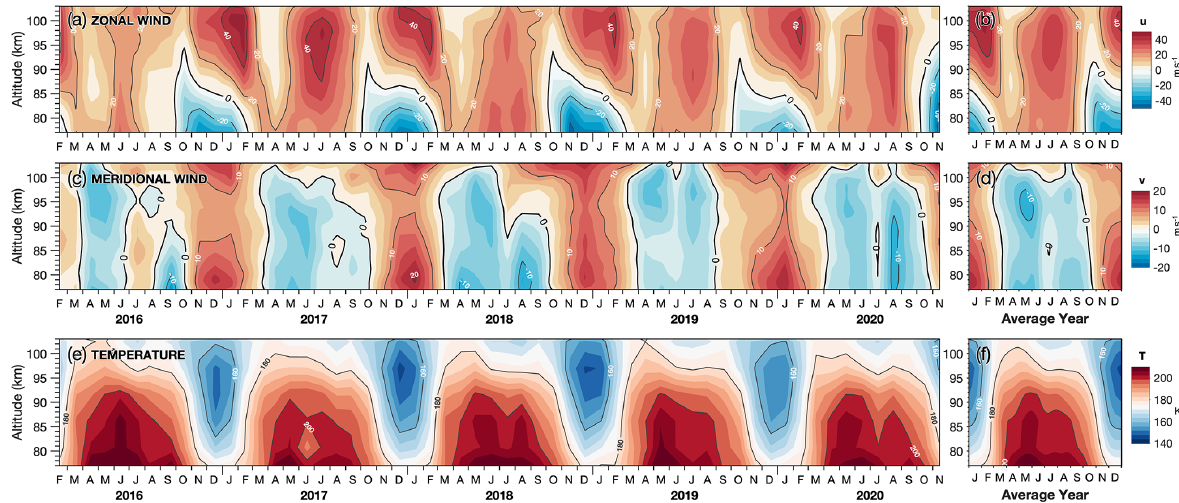
Figure 4. Monthly mean zonal and meridional winds (a–d) in the MLT from radar measurements over South Georgia during 2016 to 2020. Panels (e) and (f) show monthly mean temperatures from MLS satellite measurements. Rightmost panels show winds and temperatures derived from an average (composite) year using all meteor detections and all temperature measurements during 2016 to